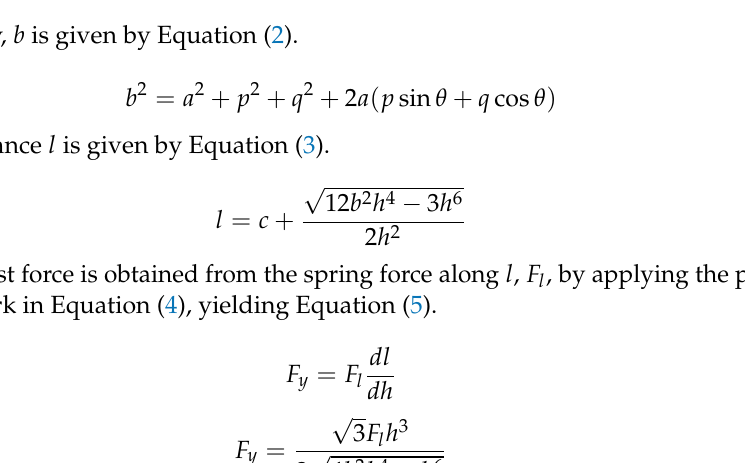
Figure 4. Linkage cage. Elastic elements, not shown in the illustration, are anchored to the knees and run along the distance l